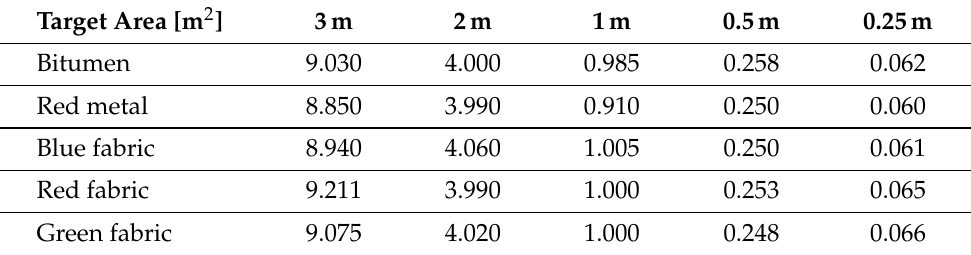
Table A1. Target areas in units of m 2 . All targets are rectangular (in most cases almost square) and the areas reported here were derived from the horizontal and vertical dimensions measured on the ground during the campaign after target deployment. Please note that the 1m red metal target is slightly smaller than planned since one special red metal piece was missing during